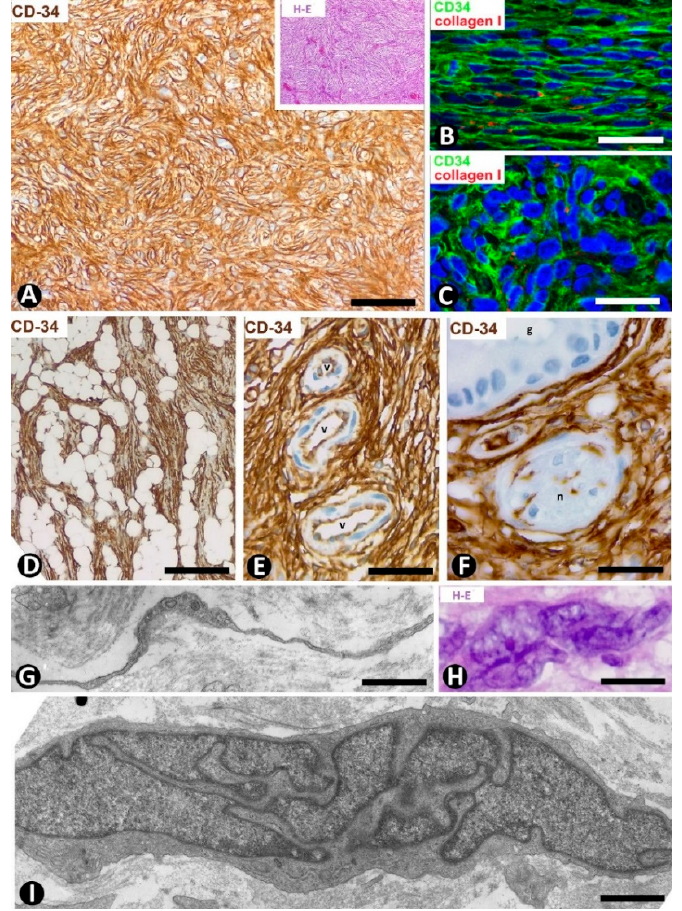
Figure 12. CD34+ stromal cells in dermatofibrosarcoma protuberans. ( A , D , F ) Immunochemistry for CD34. Hematoxylin counterstain. Insert of ( A ), and ( H ): Hematoxylin–eosin staining. ( B , C ) Double immunofluorescence labelling for CD34 (green) and Collagen I (red). DAPI counterstain. ( G , I ) Ul- trathin sections. Uranyl acetate and lead citrate. ( A ) Proliferation of CD34+stromal cells in a stori- form or intersecting (cartwheel) pattern. Insert of ( A ) Similar image in hematoxylin–eosin staining. ( B , C ) CD34+ neoplastic stromal cells (green) densely packed with low quantity of Collagen I (red). ( D ) Tumor extending into the subcutaneous adipose tissue. ( E , F ): Vessels (E, v) and sweat glands (F, g) and a nerve (F, n) are observed between masses of CD34+ neoplastic stromal cells. ( G ) A typical process of neoplastic cells with telopode characteristics (arrow). ( H , I ) Nuclei of neoplastic cells showing a characteristic convoluted and map-like appearance at high magnification in hematoxy- lin–eosin staining ( H ) and ultrastructurally ( I ). Bar: ( A , D , E ) 80 µm, ( B , C , F ) 45 µm, ( G , I ) 4 µm, ( H ) 15 µm.